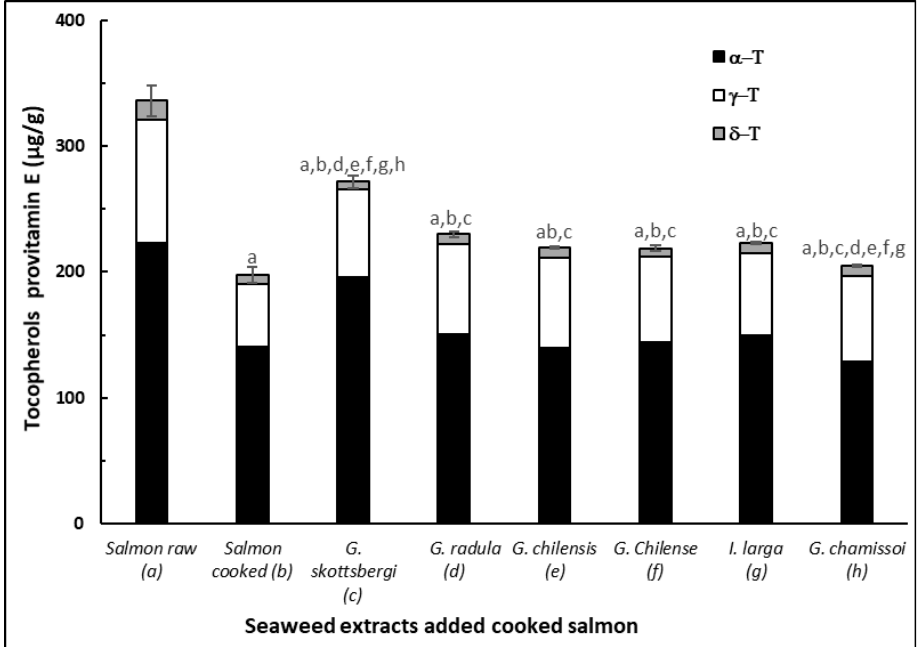
Figure 4. Tocopherols of cooked and raw salmon pastes added with different extracts of red algae: a) Raw salmon paste, b) Cooked salmon paste, c) G. chamissoi , d) G. skottsbergii , e) G. radula , f) I. larga , g) G. chilense , h) G. chilensis . Values are expressed as means ( n = 3) ± standard deviation. Different letters correspond to mean values with significant difference ( p < 0.05).